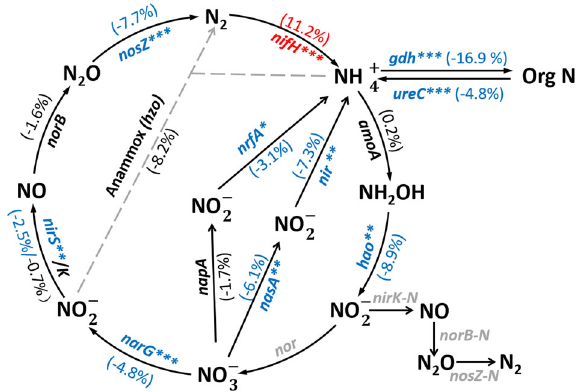
Fig. 2 The warming effect on nitrogen (N) cycle genes. The percentages in brackets indicate changes in mean abundances of functional genes between warmed and control samples, with red and blue colors representing increase and decrease, respectively. Black color represents no signi fi cant changes in the abundances by warming. Gray color represents genes which are not targeted by the version of GeoChip used here, not detected or not applicable. The signi fi cant differences between warmed and control sites were analyzed by two-tailed paired Student ’ s t -tests ( n = 4). * P < 0.10, ** P < 0.05, *** P <